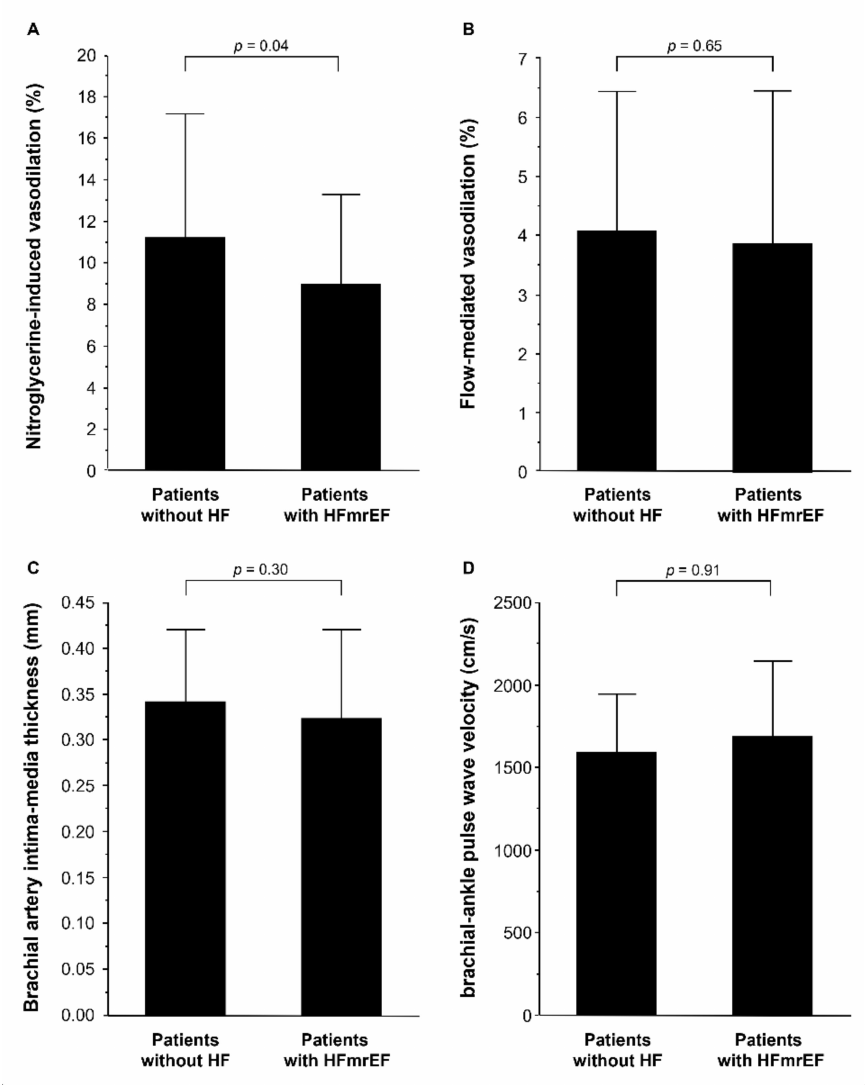
Figure 2. Bar graphs show nitroglycerine-induced vasodilation ( A ); flow-mediated vasodilation ( B ); brachial intima-media thickness ( C ), and brachial–ankle pulse wave velocity ( D ) in patients without heart failure (HF) and patients with heart failure with mildly reduced ejection fraction (HFmrEF) in propensity match